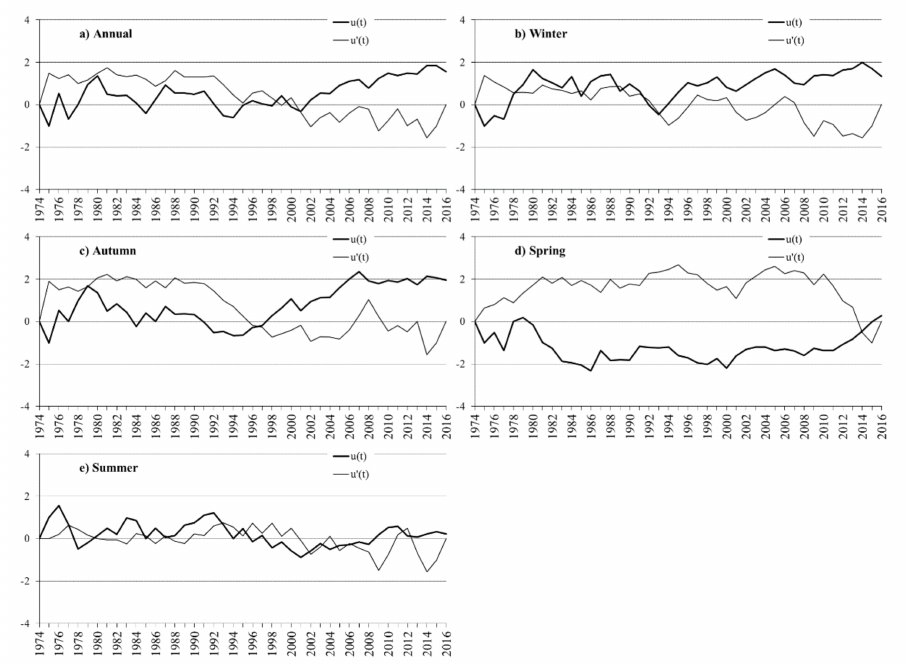
Figure 3. Graphical representation of the series u ( t ) and the retrograde series u ’( t ) of the sequential version of the Mann–Kendall test for ( a ) annual, ( b ) winter, ( c ) autumn, ( d ) spring, and ( e ) summer precipitations in the University Forest of